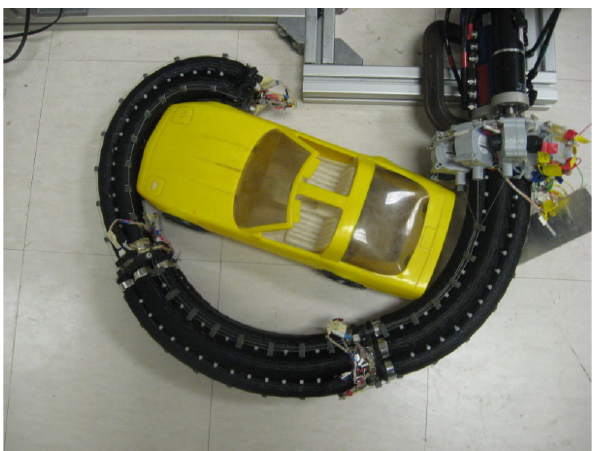
Figure 8. Continuum and point contacts.